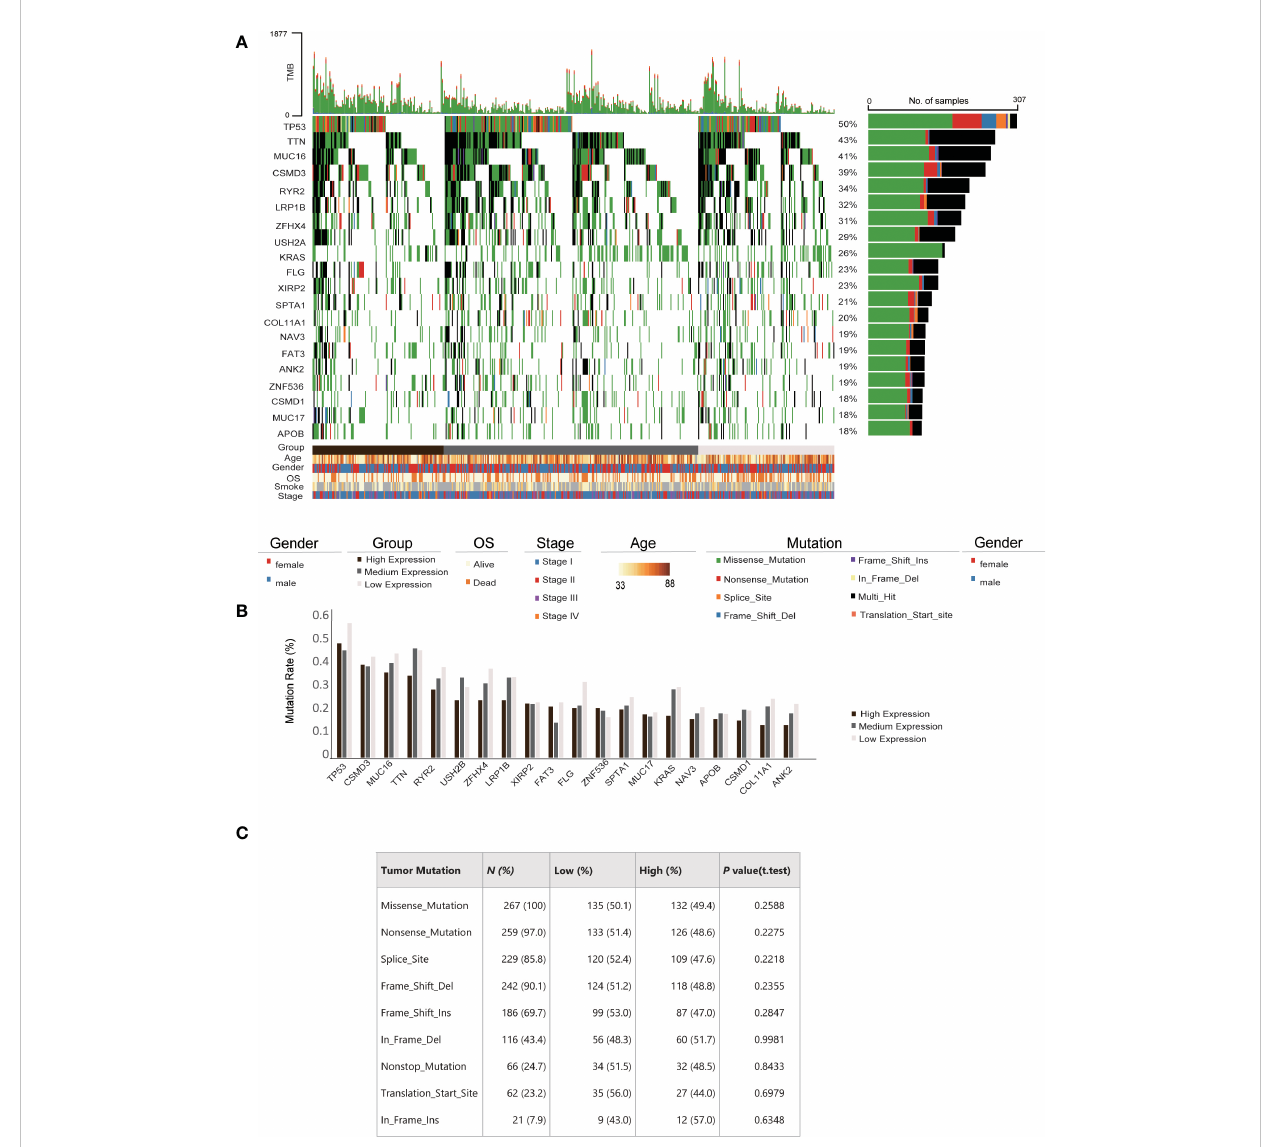
FIGURE 3 Correlation between IRAK1BP1 expression and mutation frequency in LUAD. (A) Distribution and type of top 20 genes with the highest mutation rates across all LUAD samples. Percentages of samples with mutations for each gene are shown at the left. Samples ranked by the expression of IRAK1BP1 from high to low (high, < 25% quantile; medium, ≥ 25% quantile and ≤ 75% quantile; low, > 75% quantile). The clinical characteristics, including age, gender, overall survival (OS), smoking history and stage, are shown at the bottom. (B) Mutation rates of genes in (A) . For each gene, the mutation rate was calculated in high, medium and low expression of IRAK1BP1, respectively. (C) Relationship between IRAK1BP1 expression levels in (A) and tumor mutation features in lung adenocarcinoma in the TCGA